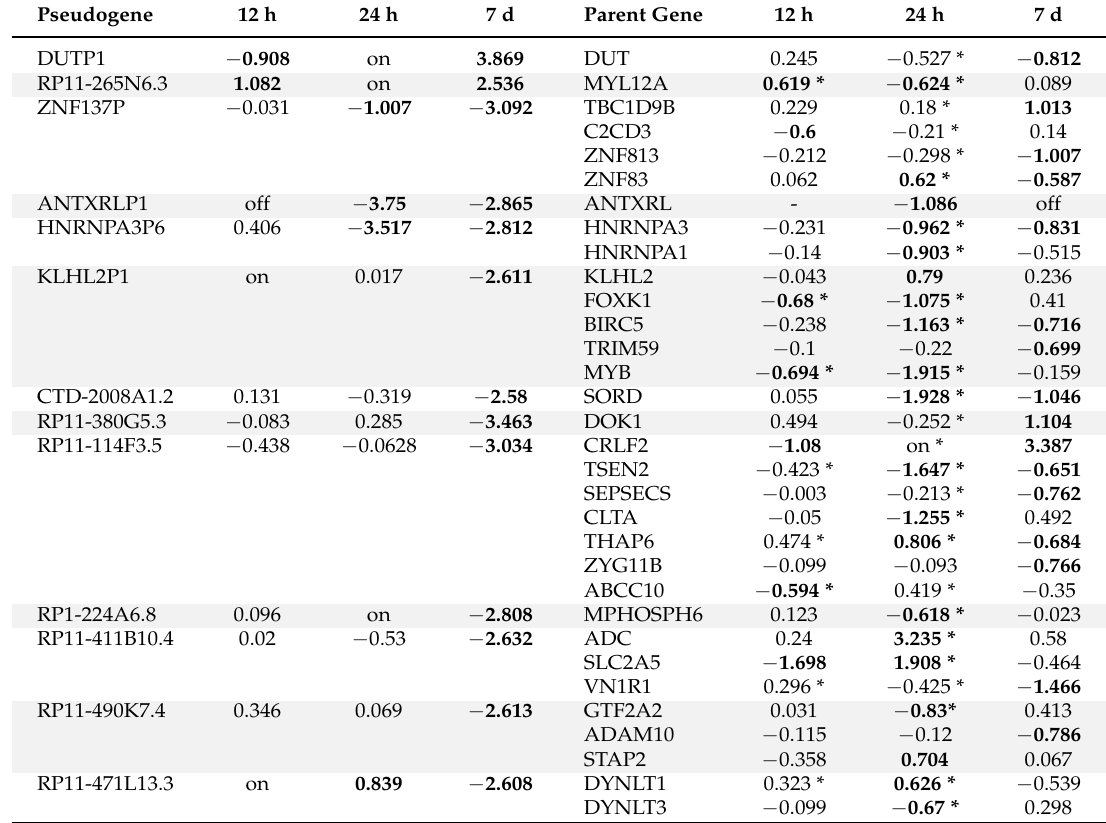
Table 4. Differentially-expressed pseudogenes in early and late HIV-1 infection. log (fold change) 2 of only those pseudogene:gene pairs are shown where the parent gene shows a >1.5-fold change in expression due to HIV-1 infection, i.e. , log (fold change) either >0.585 (upregulated) or < − 0.585 2 (downregulated). The time points (12 h, 24 h or 7 days post-infection) where the genes show a >1.5-fold change in expression are highlighted in bold. The genes that are upregulated or downregulated in all of the replicate observations (nine observations for 12 h and six observations for 24 h time-points) are identified by *. “on” genes are those that show detectable expression in HIV-1-infected cells only, and “off” genes show detectable expression in uninfected cells only. The log (fold change) at the 12-h and 24-h time points is the average log (fold change) over replicate 2 2 observations. Supplementary Table S2 lists log (fold change) in each replicate. ANTXRL did not have 2 detectable gene expression in any of the nine observations at 12 h